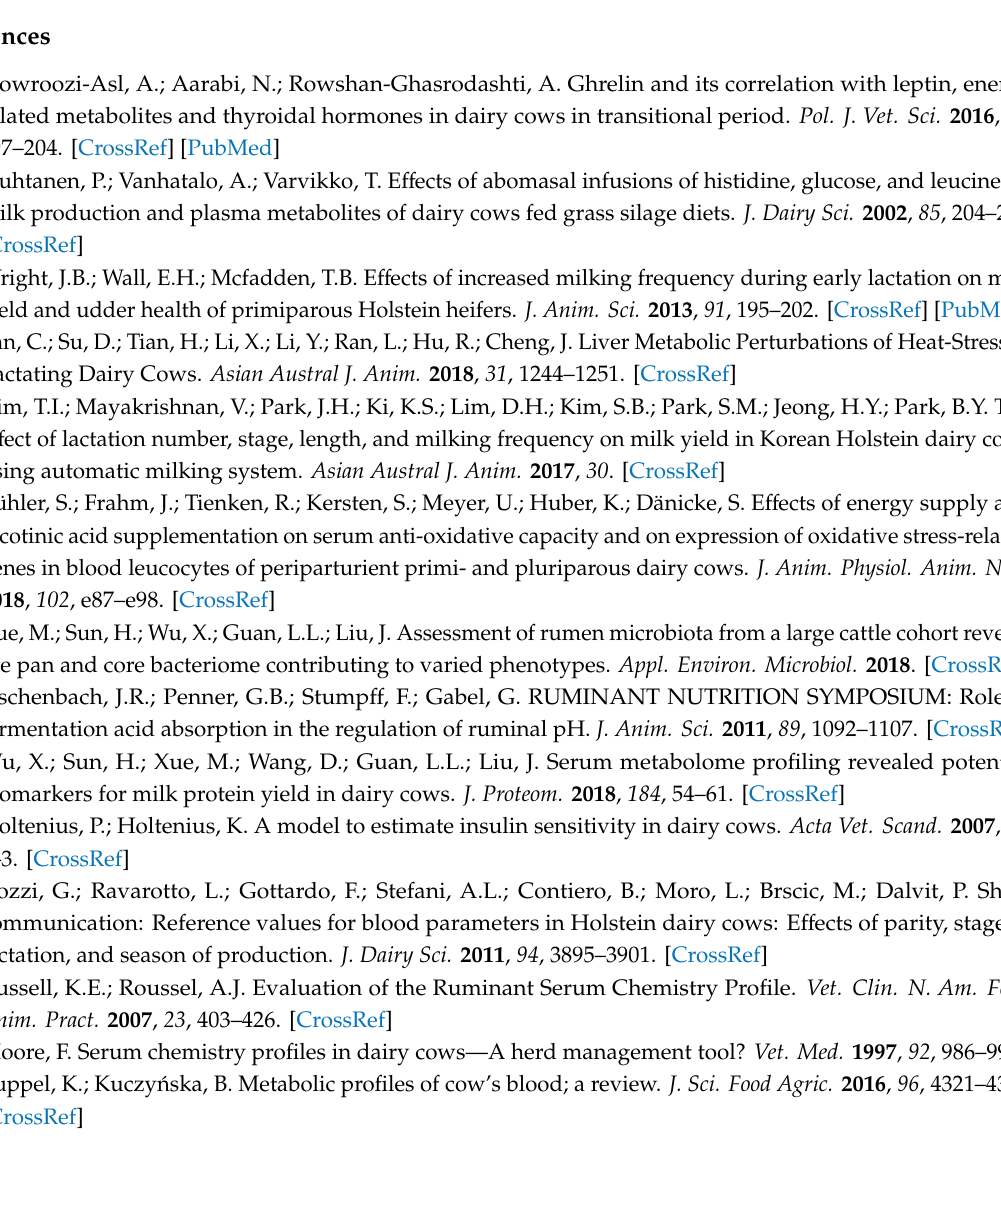
Table S1: Ingredients and nutrient compositions of the experimental